Question: What kind of plot is shown here?
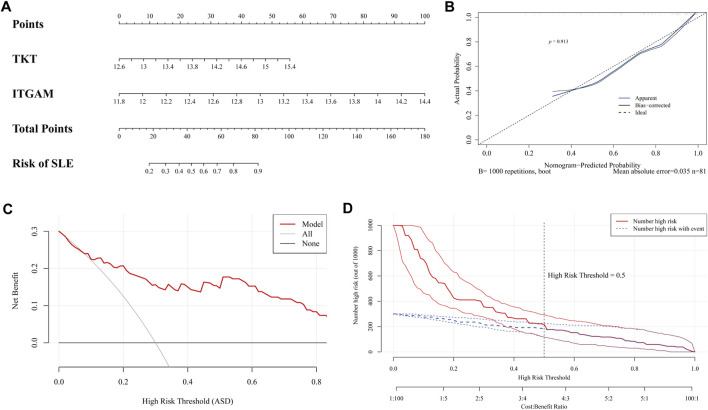
Answer: line